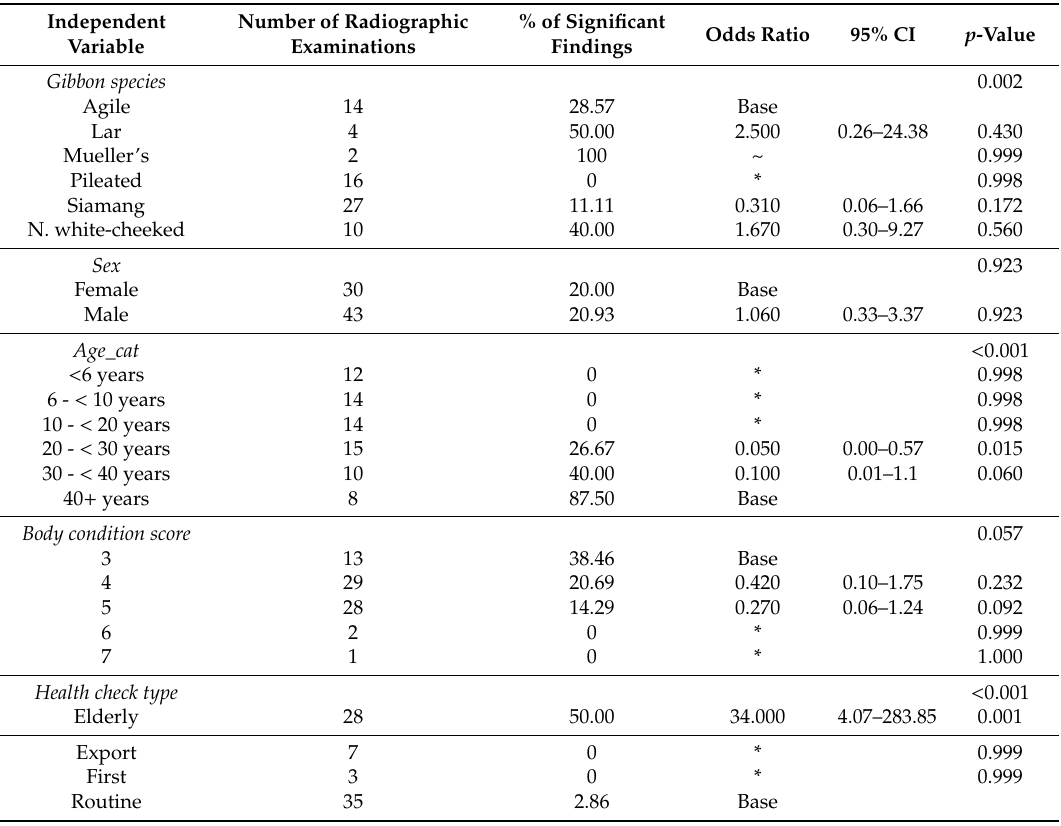
Table A1. Univariable logistic regression results for variables associated with a significant radiographic finding during elective health checks carried out on gibbons between 2011 and 2018.